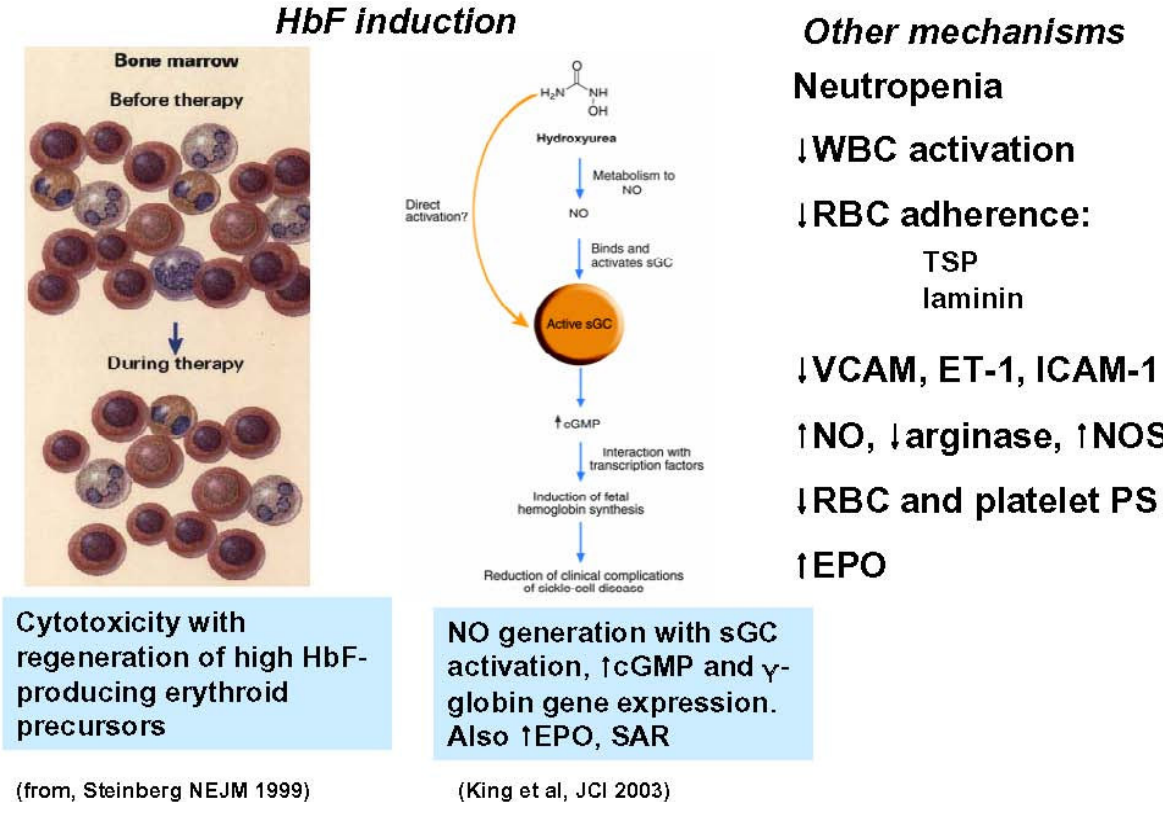
FIGURE 5. Mechanisms of action of hydroxyurea in sickle cell anemia[2,158]. Most evidence favors a primary effect of hydroxyurea on erythroid progenitor populations. Other mechanisms of action are possible, but some observations might be a result rather than a cause of HbF